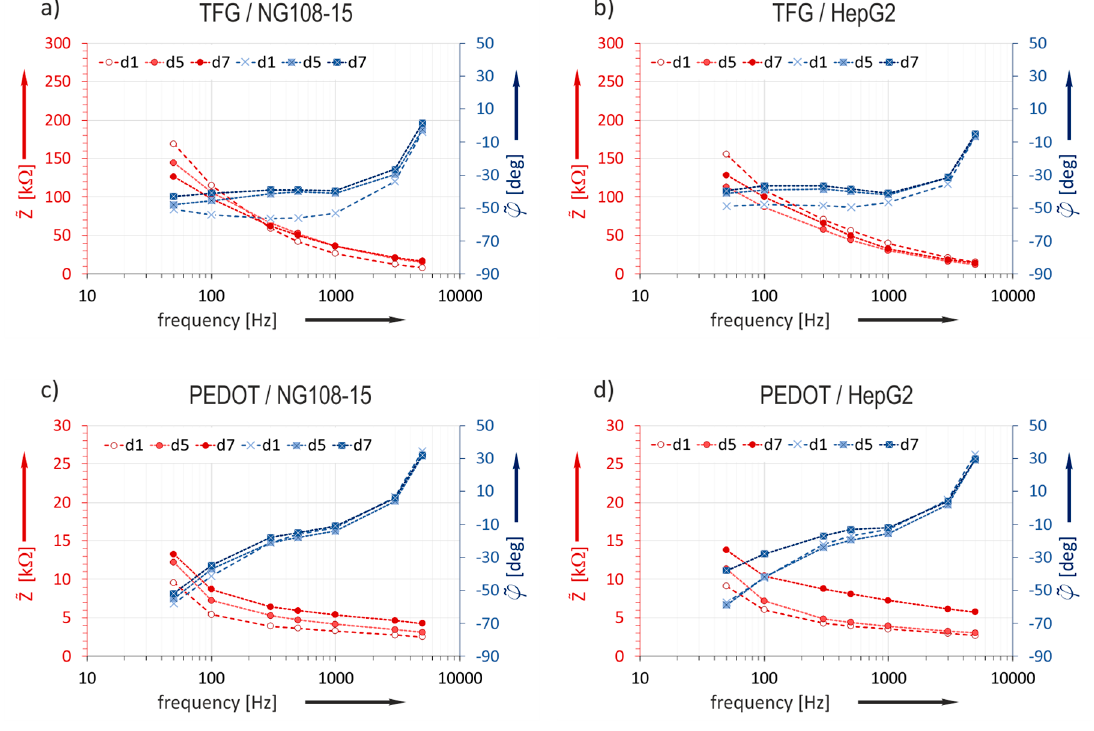
Figure 6. Bode diagrams of median values obtained from measurements in cell culture NG108-15 and HepG2. Frequency varies from 50 Hz to 5 kHz: ( a ) NG 108-15 cultured in TFG-MEAs; ( b ) HepG2 cultured in TFG-MEAs; ( c ) NG 108-15 cultured in PEDOT-MEAs and ( d ) HepG2 cultured in PEDOT-MEAs.